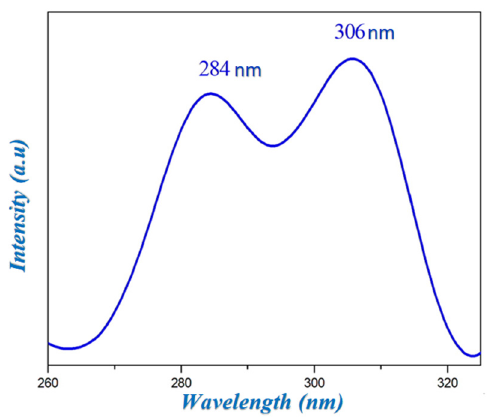
Figure 7. Emission spectrum of HTN.